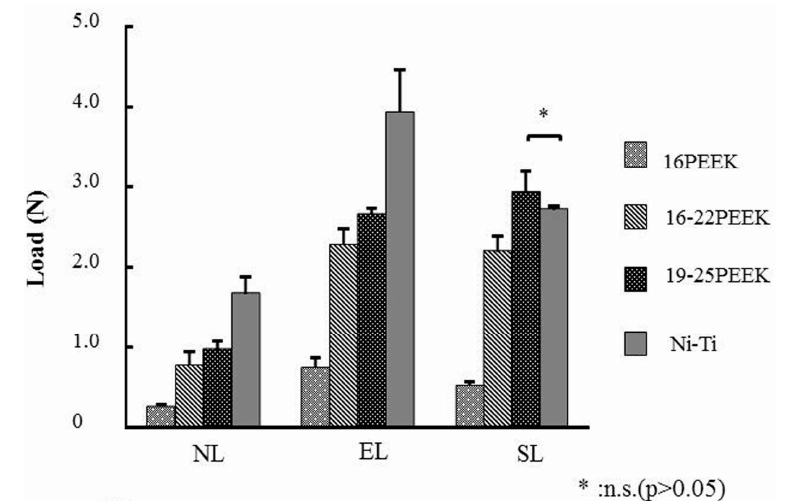
Figure 2. Load values of each wire at a maximum deflection of 2000 µ m for the respective ligation methods.